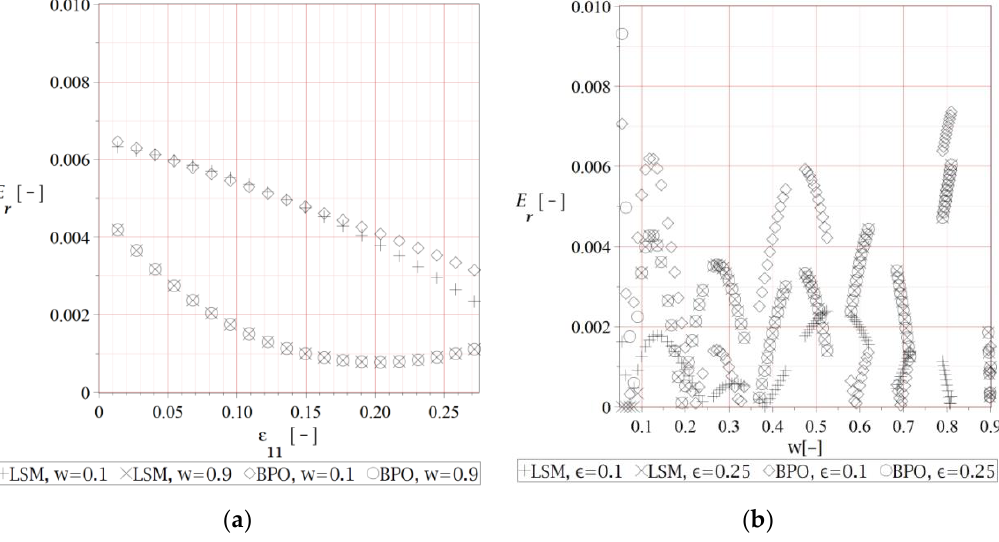
Figure 7. Relative error of effective deformation energy approximations w.r.t. ( a ) the strain level 𝜀 11 and ( b ) the interface defects volume fraction 𝑤 .